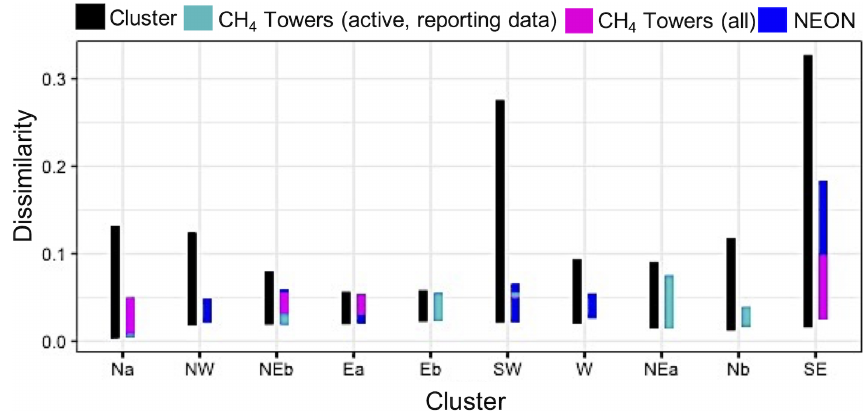
Figure 4. The range in dissimilarity for clusters (black bar), active CH 4 towers providing CH 4 data to AmeriFlux (cyan), all active CH 4 towers (magenta), and for NEON towers (blue). The black lines show the range in dissimilarity observed for a cluster and greater overlap between the cluster range and the tower range is important for landscape